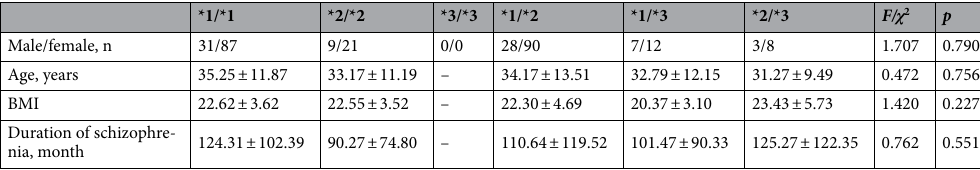
Table 1. Characteristics of study population. *1/*1: 681GG, 636GG; *1/*2: 681GA, 636GG; *1/*3: 681GG, 636GA; *2/*2: 681AA, 636GG; *2/*3: 681GA, 636GA; *3/*3: 681GG, 636AA.